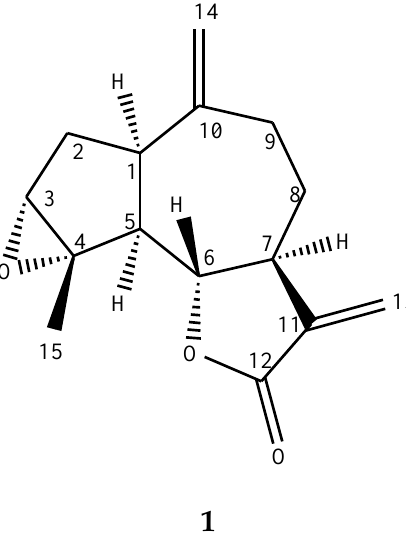
Figure 1. Structure of estafiatin 1.